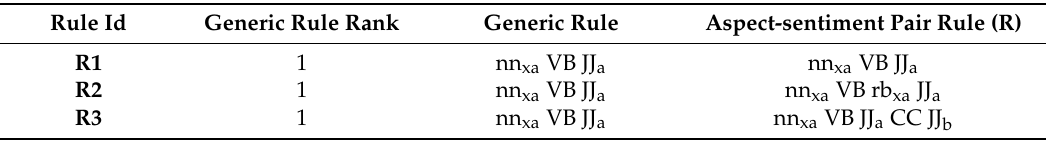
Table 8. Generic rules with its corresponding aspect-sentiment pair